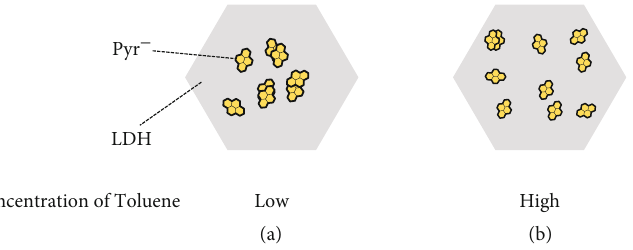
Figure 10: Schematic view of Pyr − in the interlayer of LDH (a) in air and (b) in the ethanol-toluene mixed